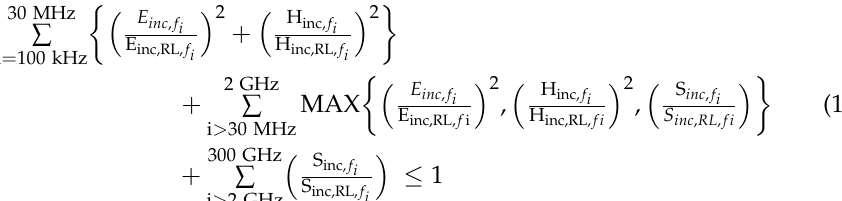
Table 1. The ICNIRP and FCC maximum limits for frequencies 0.1 MHz to 300 GHz.